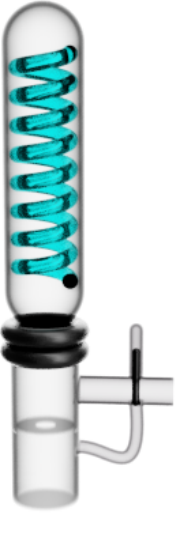
Figure 3. Distillation column condenser.